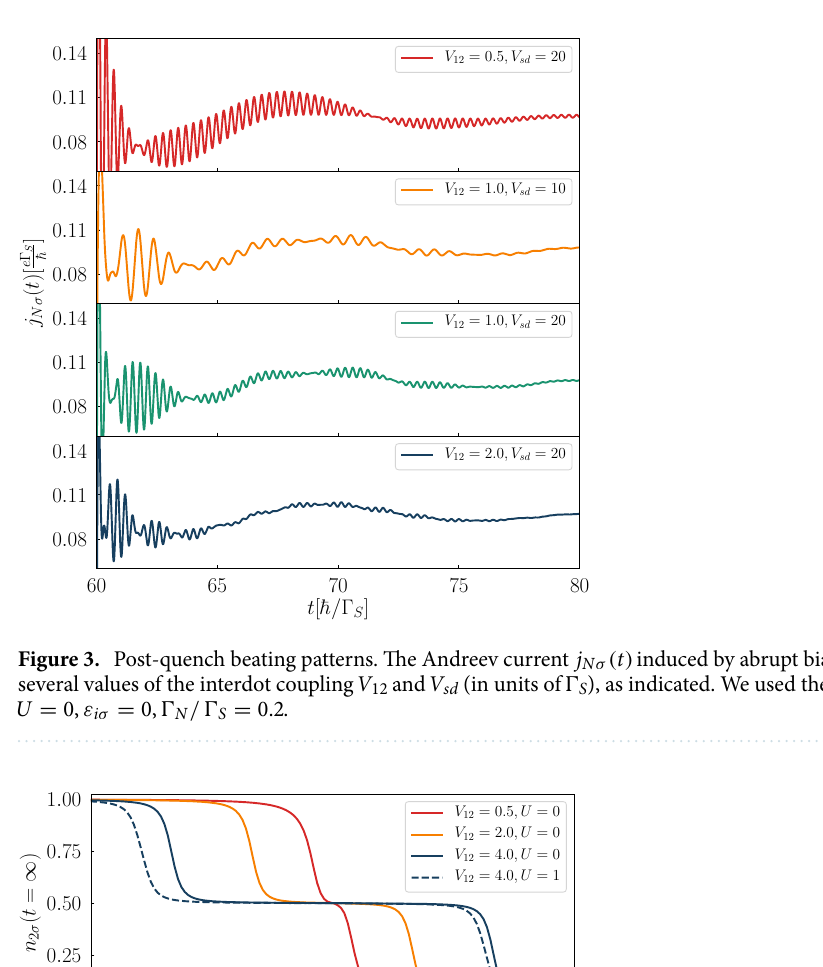
) of the QD 2 occupancy as a function of the energy = ∞ 0.1 , Ŵ 1 0 , Ŵ N = S = sd =